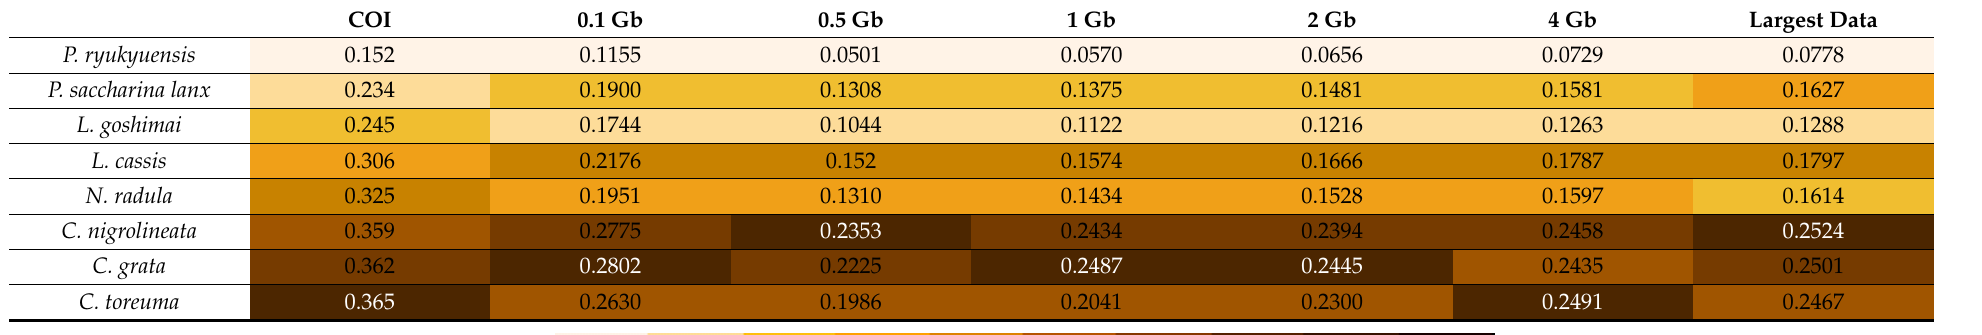
Color from light to dark: .